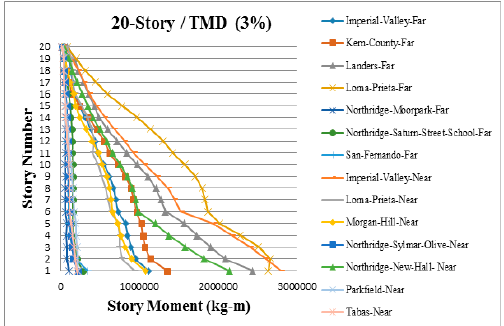
Figure A25. Peak story moments for 20-story fixed-base building with 1 TMD.